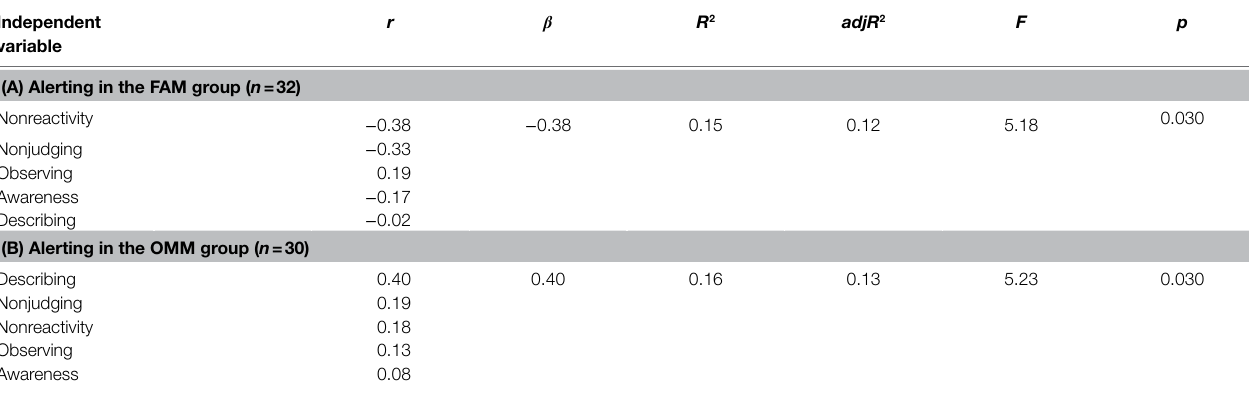
TABLE 2 | Results of stepwise linear regressions in the combinations in which changes in ANT score could be predicted by FFMQ factors (after removing outliers). Independent